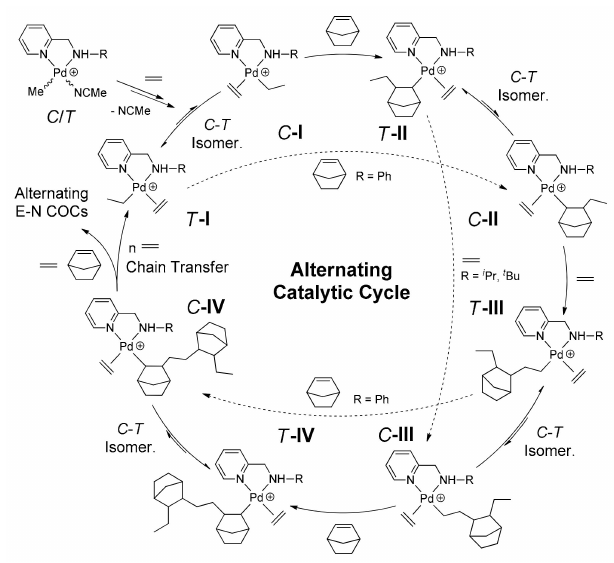
Scheme 8. Alternating Catalytic Cycle of E–N Copolymerization. (Solid line: R = 2,6-Me 2 C 6 H 3